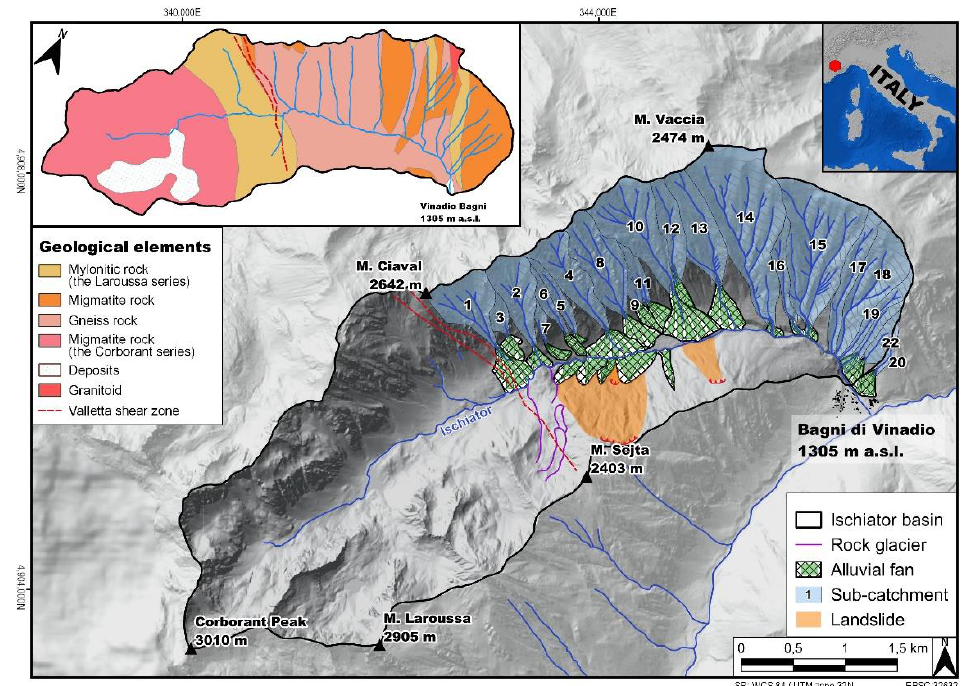
Figure 3. Geology–geomorphology and slope instability processes in the Ischiator catchment (1:10,000 scale). The area investigated is shown with n. 22 subcatchments (the Comba Vaccia torrent, detailed in the text, is n. 14). In the outer limit of the map, the geographical coordinates in the UTM–WGS84 system, zone 32T, are shown.